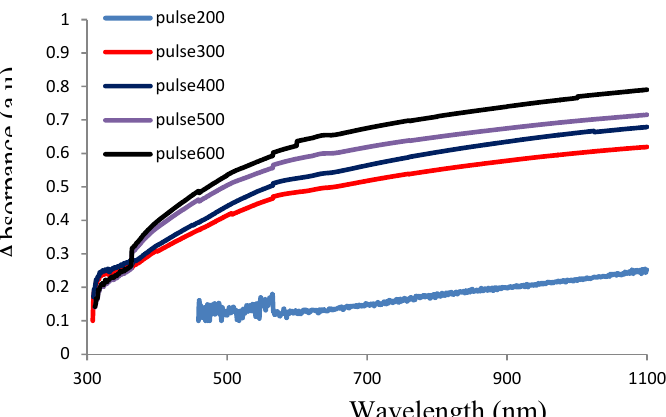
Fig.6: The absorption spectra of ZnO-CuO-ZnO films deposited on glass substrate at a different number of laser